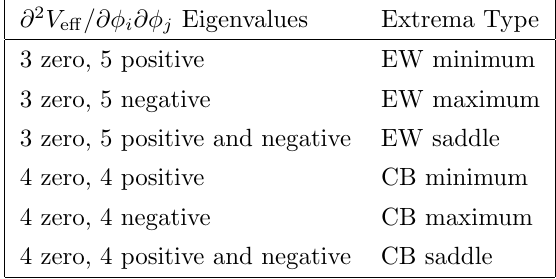
Table 1. Characterization of the extrema of the 2HDM e(cid:11)ective